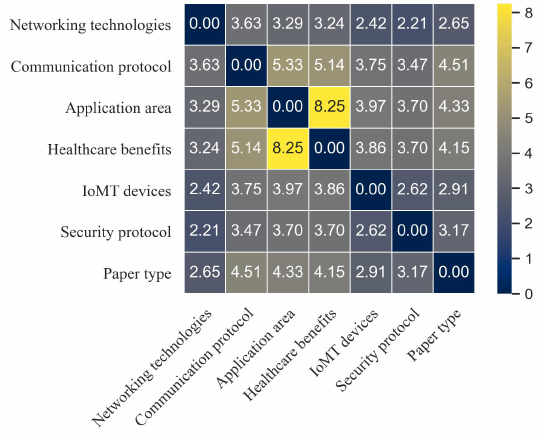
Figure 14. Standard deviation values of different dimensions of our